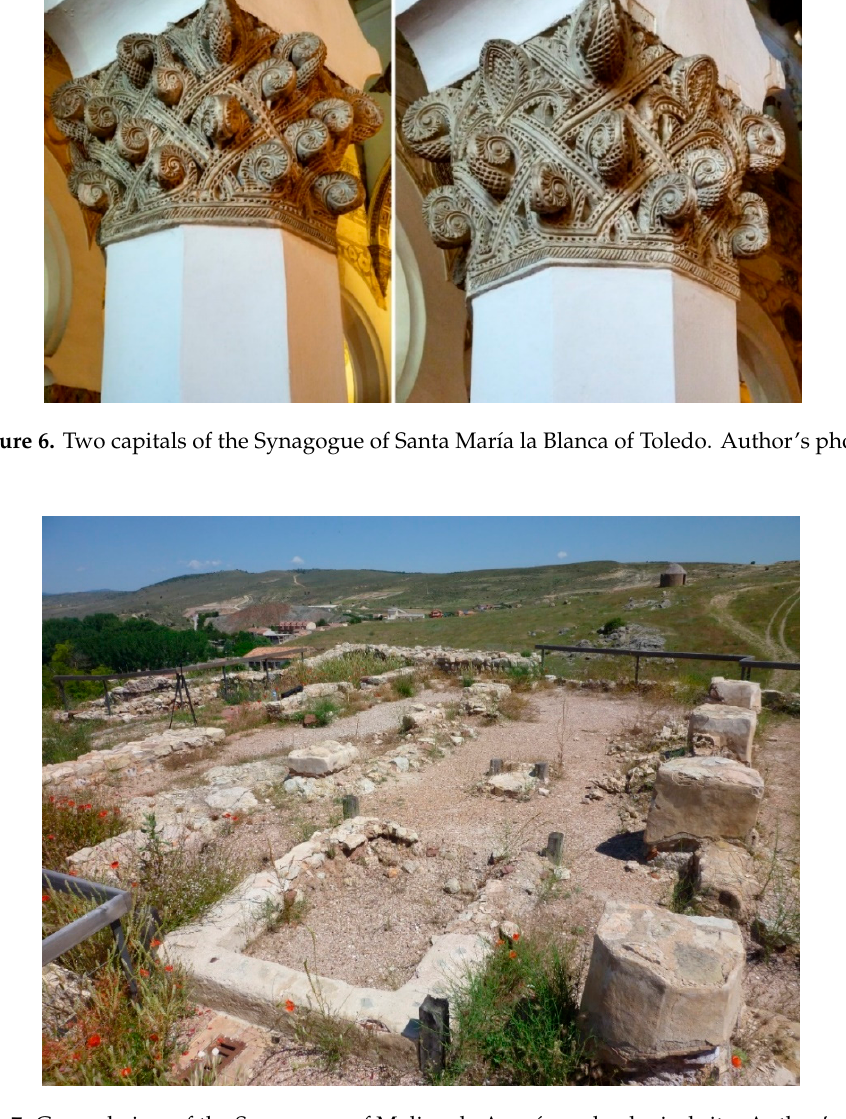
Figure 7. General view of the Synagogue of Molina de Aragón archeological site. Author’s photo.